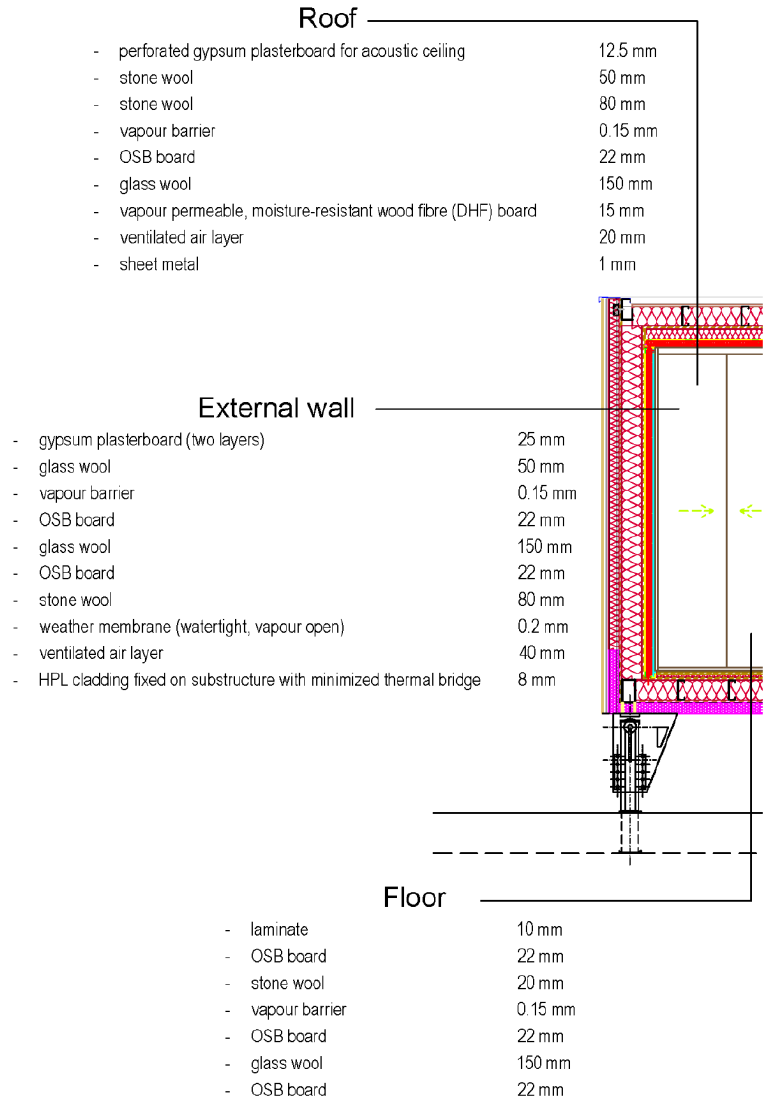
Figure 6. MUZA’s opaque envelope assemblies.